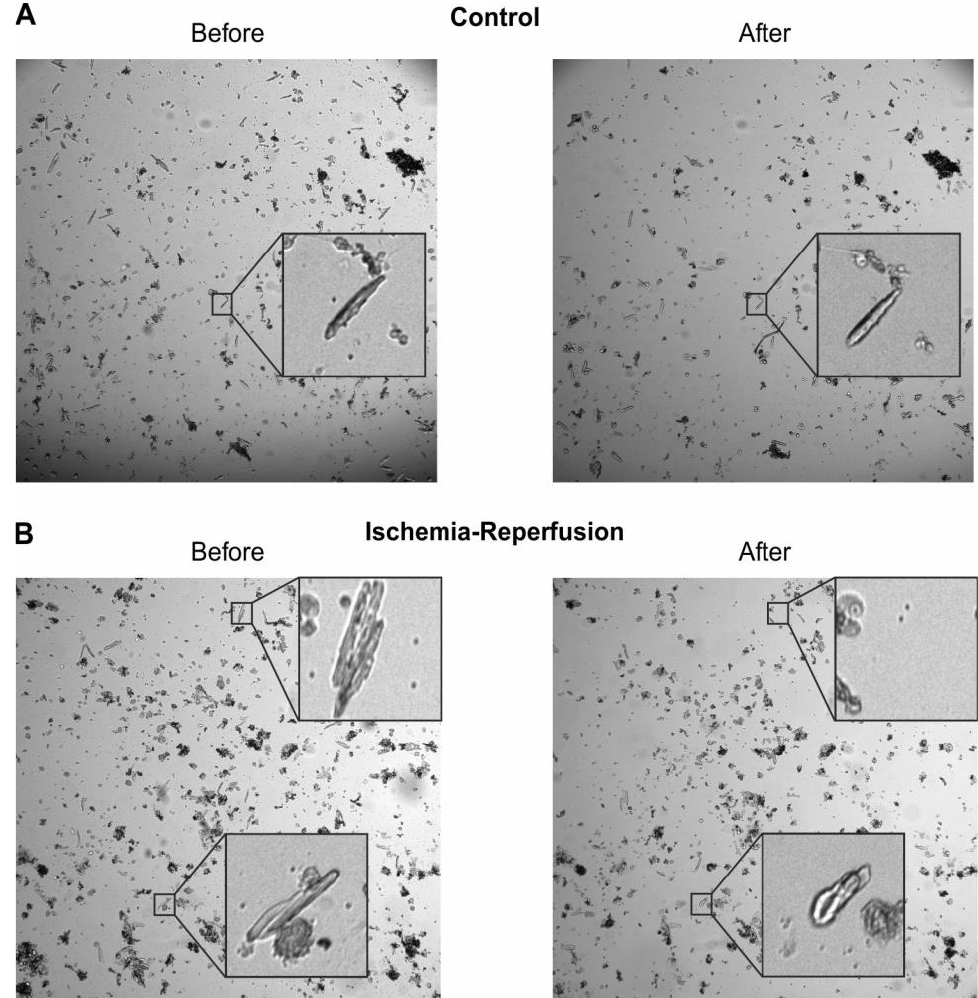
Figure A3. Cardiomyocytes either survived, were lost, or were damaged during experiments. These images were taken either before and after control ( A ) or IR ( B ) conditions were applied. Exemplary cells have been magnified 7-fold, with the inset in panel a showing a cardiomyocyte that survives the cellular model for IR without relevant morphological changes, the upper inset in b showing cardiomyocytes that disappear from the spot and the lower insets showing two cardiomyocytes that round-up as sign of irreversible damage. Images were acquired with identical settings and are visualised with identical brightness and contrast. Magnified insets have an edge length of 93 µ